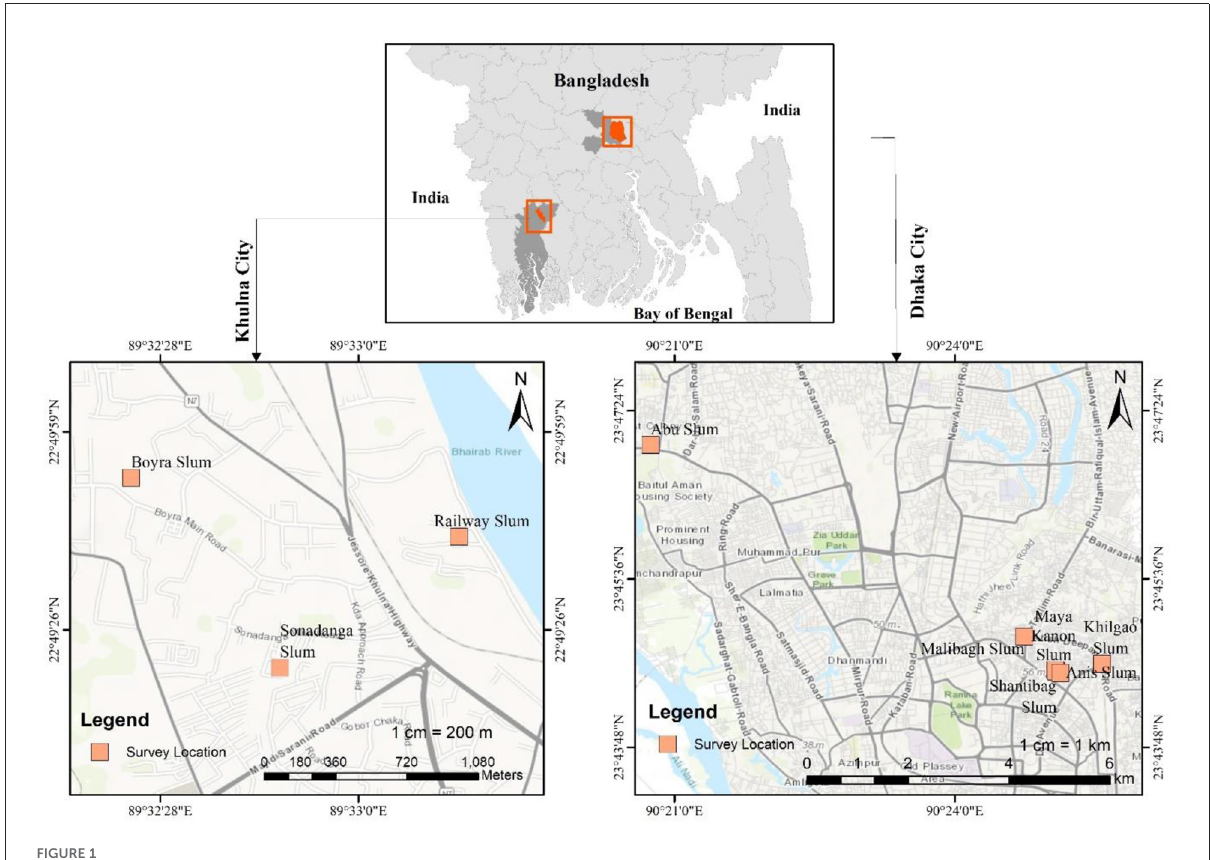
FIGURE1 Study survey